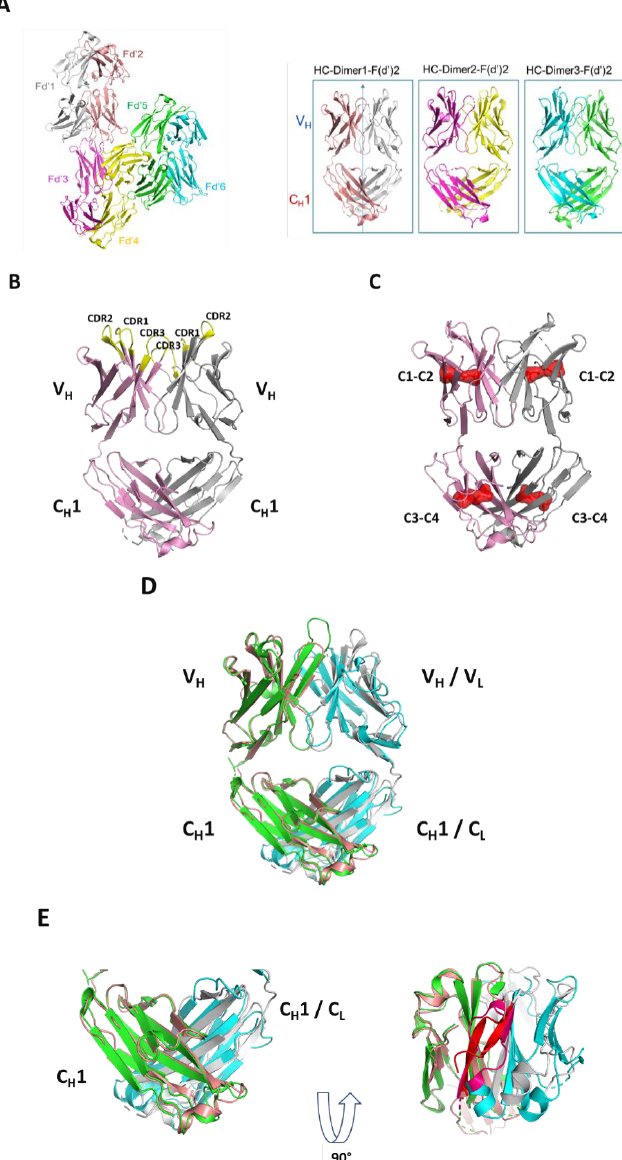
Figure 6. ( A ) Three HC or Fd dimers were found in asymmetric unit. All 3 dimers are similar and have the same topology except for minor differences in electron density in flexible regions. “HC - Dimer1- Fd2” (dimer of Fd’1 and Fd’2 domains) was chosen for evaluating structural features such as interfacial contacts, CDR topology, and comparisons to a representative Fab domain. ( B ) Ribbon diagram of the highly symmetrical HC dimer Fd2-A (PDB accession code 7KQY). One Fd chain is colored light purple and the opposing chain is gray. CDR loops are yellow and labeled. This representation is the same HC dimer as “HC -dimer1- Fd2” shown in part A. ( C ) Fd2-A with each intramolecular disulfide bond highlighted red in transparent surface and labeled with the same notation used in Figure 5 (C1, C2, etc., where C1 is disulfide bonded to C2 and C3 bonded to C4) ( D ) Superposition of Fd2-A dimer (shown as salmon for chain A and gray for chain B) and HC-LC of a Fab (PDB accession code 5vsi). The Fab HC (or Fd) chain is in green and the LC is in turquoise. ( E ) Superposition of the Fd2 C H 1 domains with 5vsi Fab C H 1 and C L domains (left) and same domain rotated back 90° (right). In the HC2-A dimerization interface, residues from C H 1 shown in red are residues HC-126 to HC-133 involved in a symmetrical interaction that is unique relative to the Fab interface. In magenta, this portion of the Fab HC-LC interface (residues HC-131 to HC-138 for 5vsi) are interactions not present in the HC2-A interface. Table 5. Crystal data collection and refinement statistics. Values in parenthesis describe the highest resolution shell. Ramachandran refers to backbone dihedral angles.